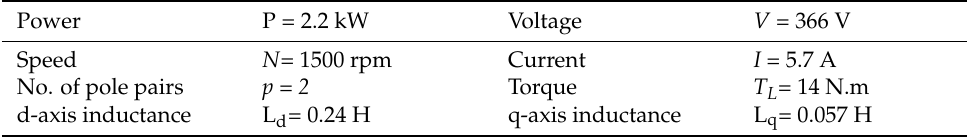
Table 3. Parameters of the used SynRM.